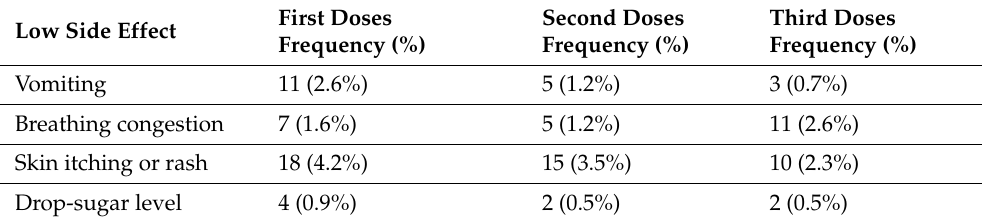
Table 3. The rare adverse effects after Pfizer, Oxford–AstraZeneca, and Moderna COVID-19 vaccina- tion (n =